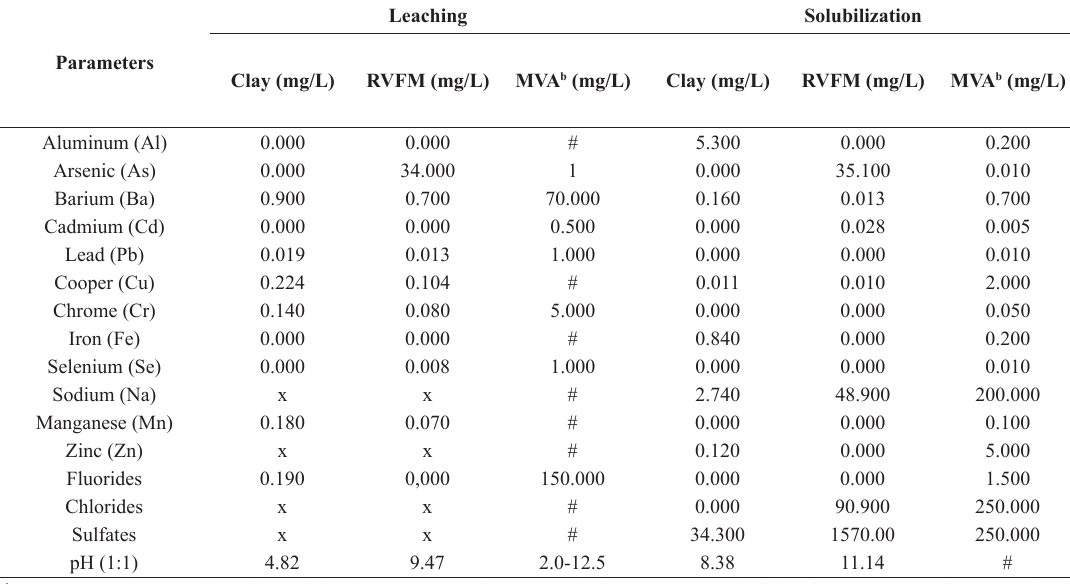
Table 5. Results of the leaching and solubilization tests according to the NBR 10004/2004 16 standard, which classified the RVFM as a non-hazardous waste (class